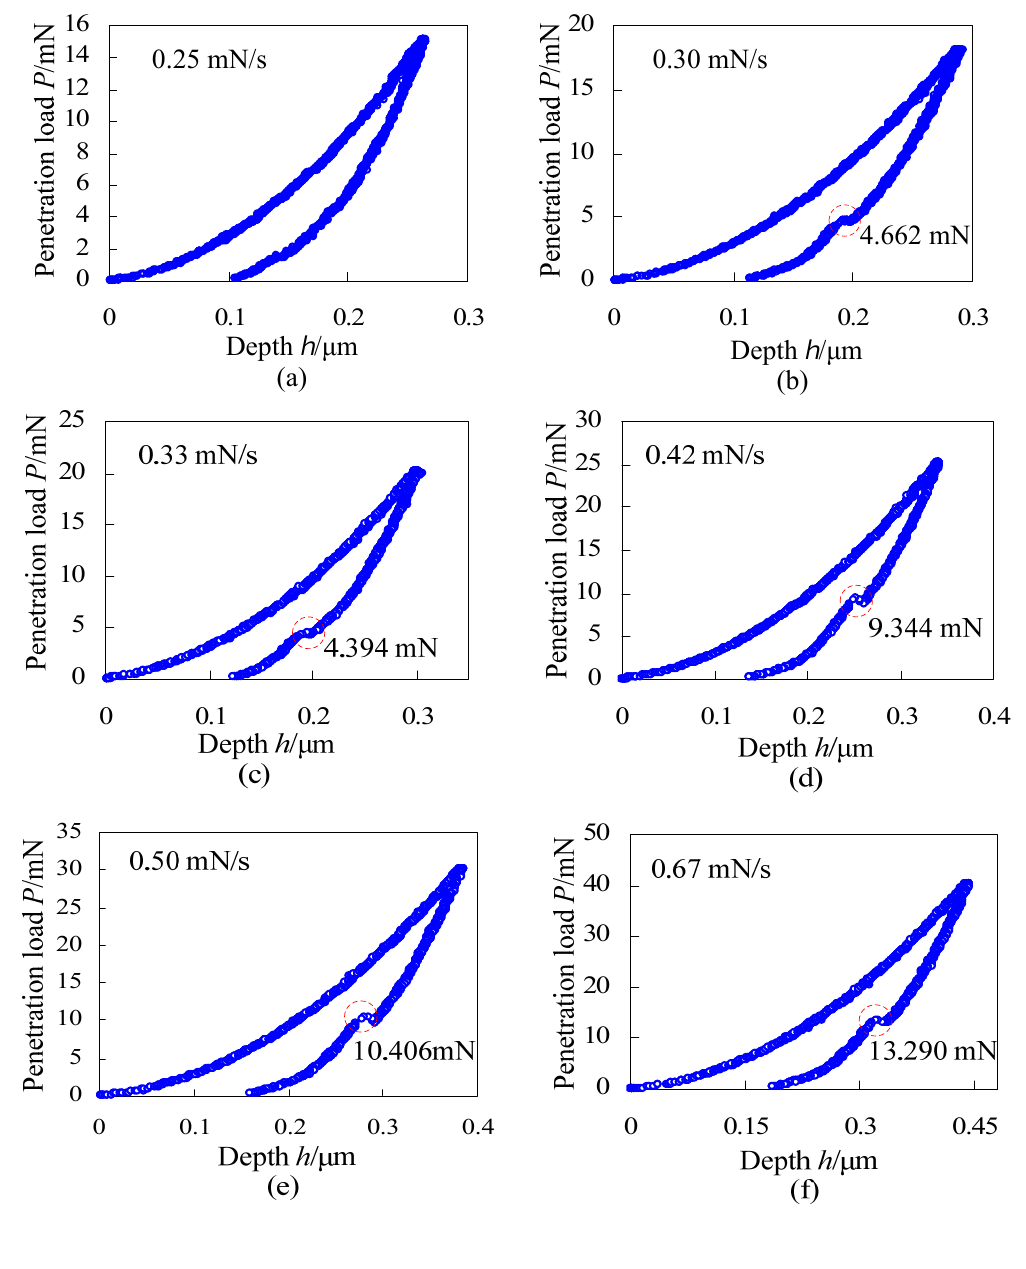
Figure 6. Load-depth curves of single crystal silicon with different maximum penetration loads and the same testing time of 100